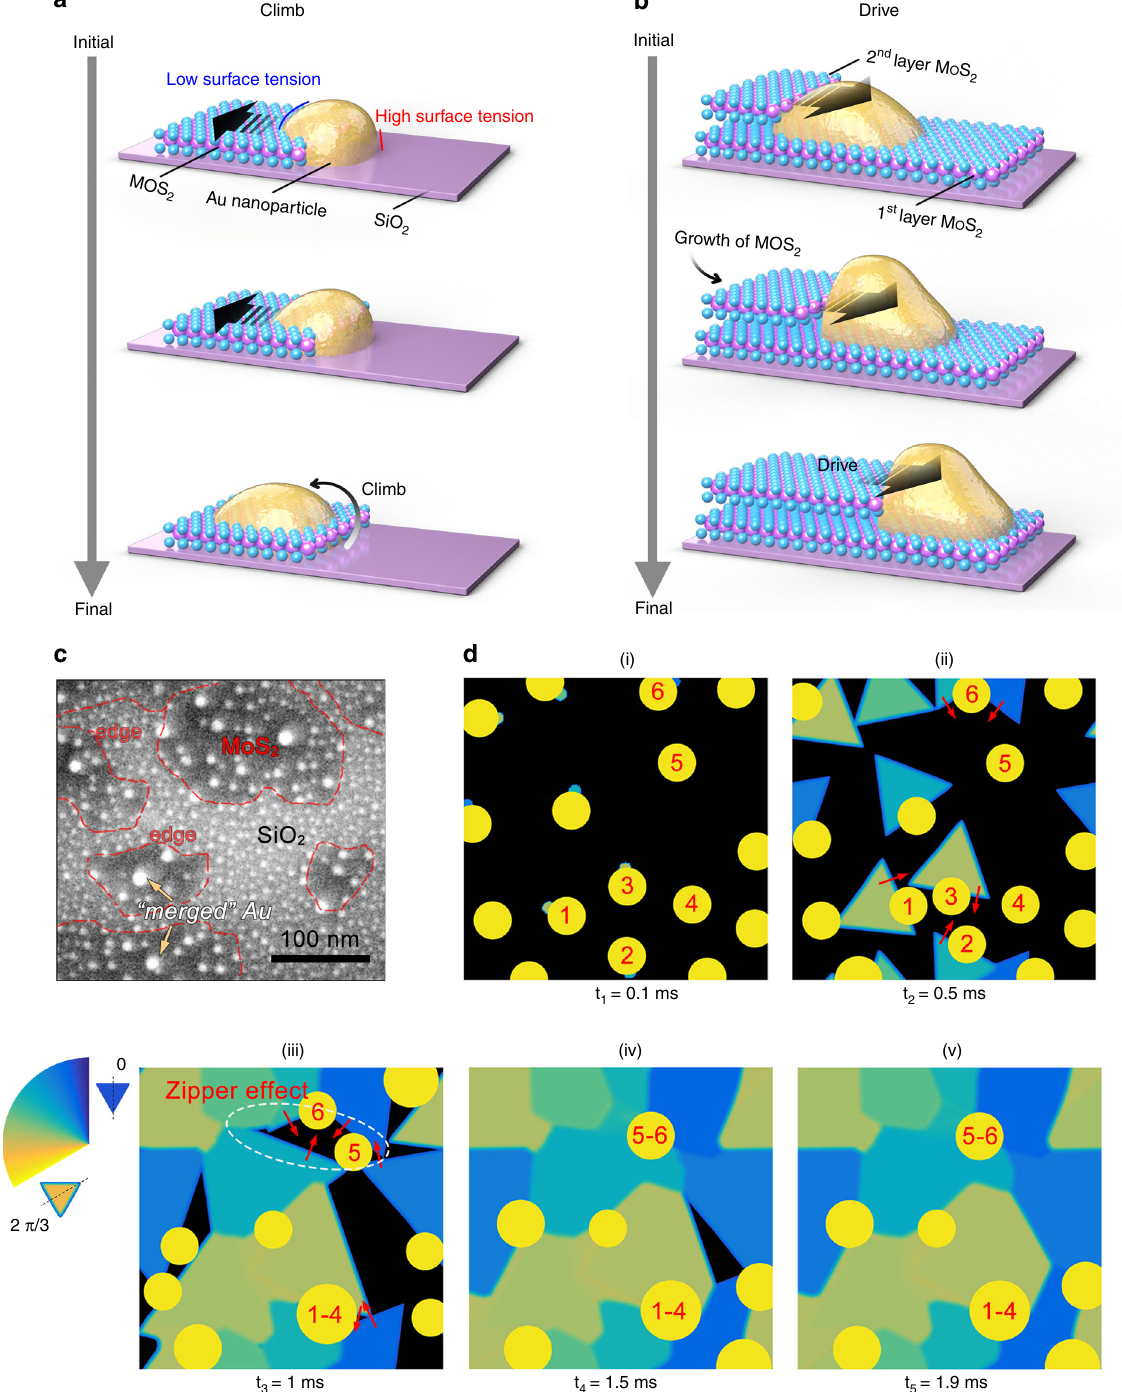
Fig. 3 Proposed self-limiting climb and drive growth mechanism of the TMD nanograin fi lms. a Schematic of the climb stage: the Au QDs droplets tend to climb onto the MoS 2 monolayer from the SiO 2 substrate due to the surface tension difference. b Schematic of the drive stage: the growth of a second MoS 2 layer tends to push the Au QDs along the growth direction. Most of the Au QDs will be stabilized at the grain boundaries in order to minimize their surface energy. c SEM image showing the distribution of the Au QDs on the edges of growing MoS 2 layers (marked by the red-dashed line). Au QDs are usually larger on the MoS 2 layers (indicated by blue arrows) than those observed on the SiO 2 substrate. d Real-time phase- fi eld simulation showing the formation of the MoS 2 nanograin fi lm. The Au QDs numbered 1 – 4 show that the growth of the MoS 2 layer will push Au QDs toward the grain boundaries. Au QDs numbered 5 – 6 show a zipper effect to suture the neighboring grains together. The movie can be found in Supplementary Movie 1 (Real-time phase- fi eld simulation of the growth